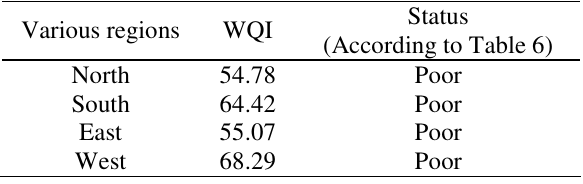
Table 6. Status of water qualities based on